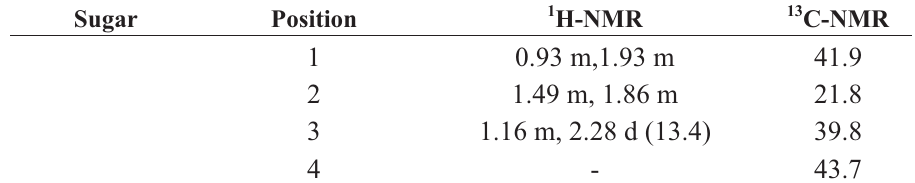
Table 1. 1 H-NMR (500 MHz, D rebaudioside M2 ( 2 ) a